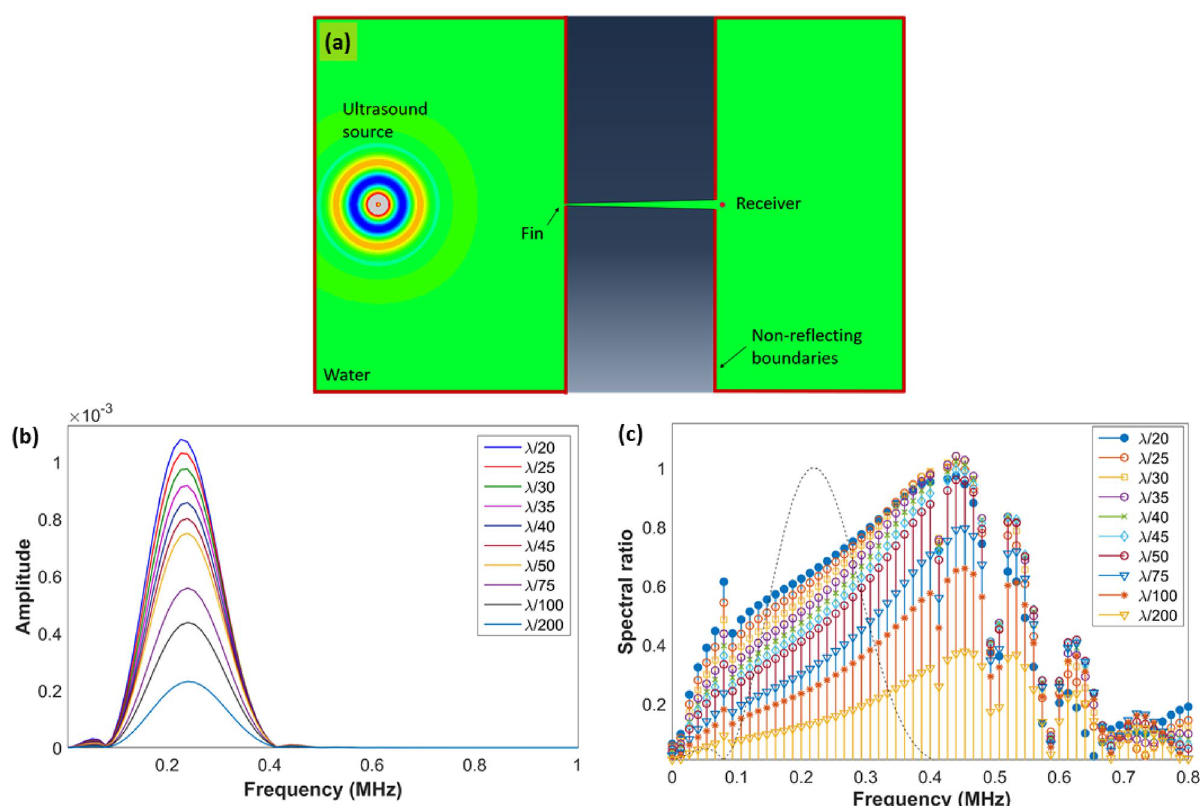
Figure 3. ( a ) Schematic of the FE model considered for the study of wave transmission past a single water-filled fin. ( b ) Frequency spectrum of the wave captured at the exit of the fin. ( c ) Spectral ratio obtained for various cases of w i . The normalized frequency spectrum of the wave received without hyperlens was shown as a dotted curve to indicate the signal’s